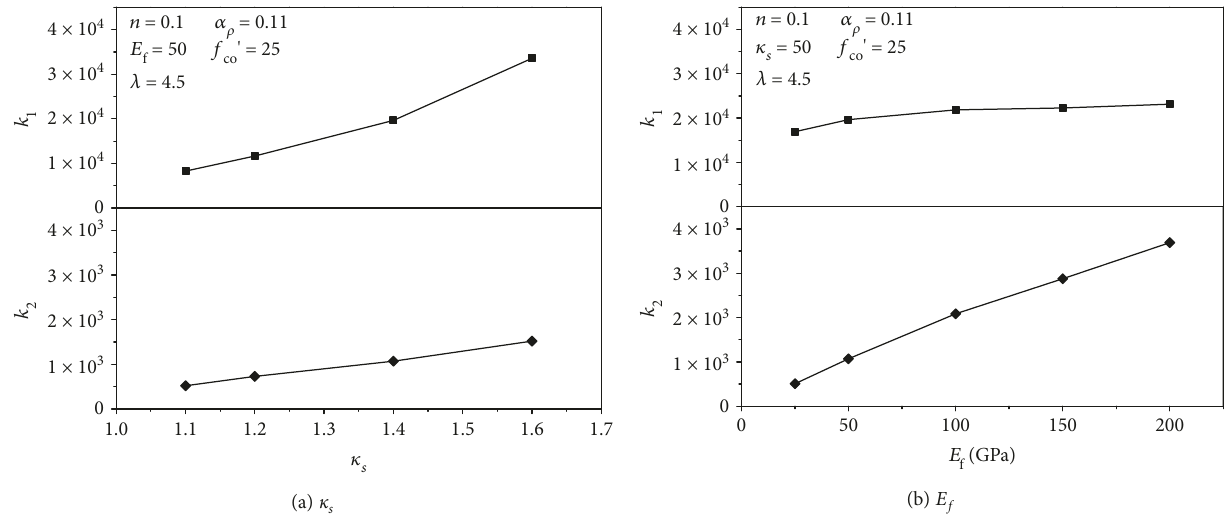
Figure 14: Variation of k